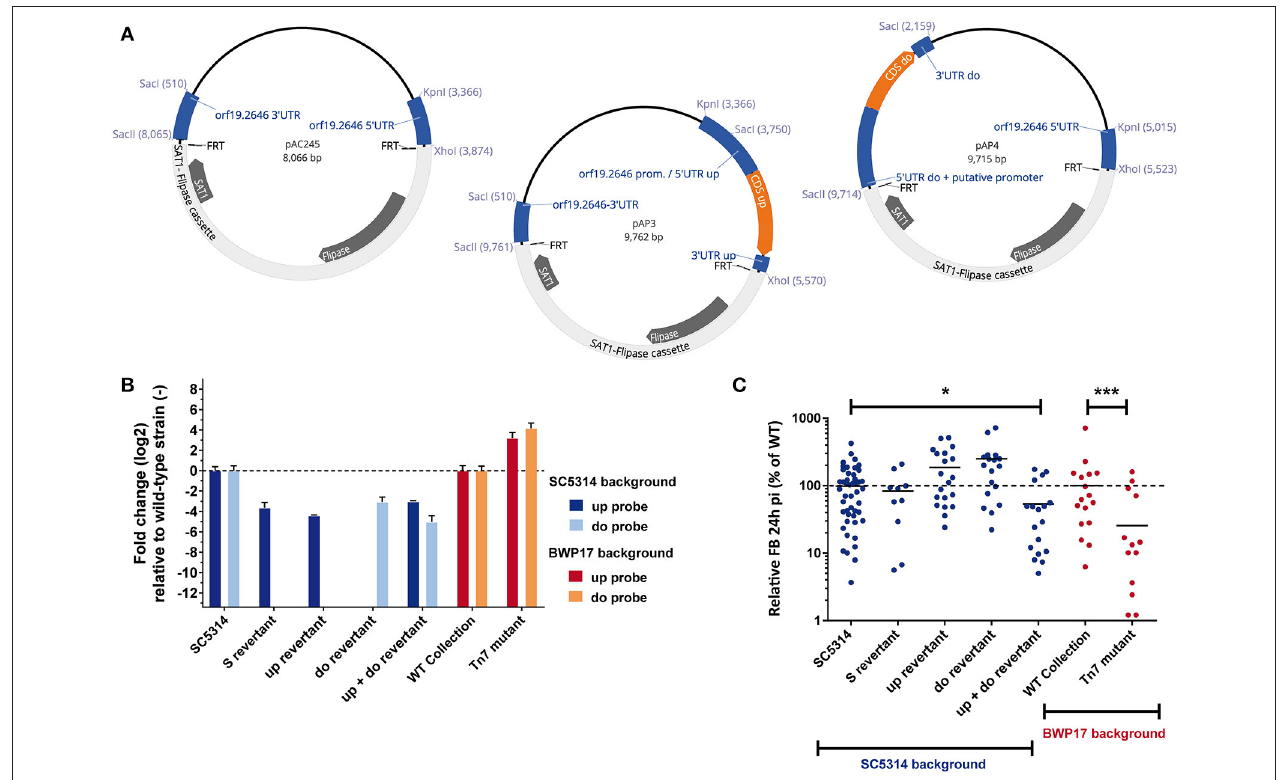
FIGURE 6 | Identification of the Tn7 up-, and downstream transcript sequences and role in the fungal burden phenotype. (A) Maps of the disruption cassettes used to introduce upstream and downstream transcripts in the deletion mutant. pAP3 and pAP4 were constructed from pAC245 by replacement of either orf19.2646 5 ′ -UTR or 3 ′ -UTR, respectively. (B) mRNA level of Tn7 putative upstream and downstream transcripts. Results are expressed relative to the quantity measured for the isogenic wild-type strain. Each bar-plot corresponds to the mean of two biological samples measured in triplicates. (C) G. mellonella fungal burden for each individual larva. The fungal burden is expressed as a percentage relative to the mean of the wild-type group in the same experiment. All experiments were pooled in this graph. The mean value of each group is indicated with a black bar. The dotted line indicates the level of the mean of the wild-type strain set at 100%. Each mutant was tested at least twice using 10 larvae each time, except for the S-revertant which was tested only twice with 5 larvae (missing dots correspond to dead larvae). Statistical analyses were performed using a ROUT analysis to remove outliers ( Motulsky and Brown, 2006), followed by a Mann–Whitney test to assess CFU differences relative to the wild-type strain (GraphPad Prism 7.02). The stars indicate the level of statistical significance: * p < 0.05, *** p <